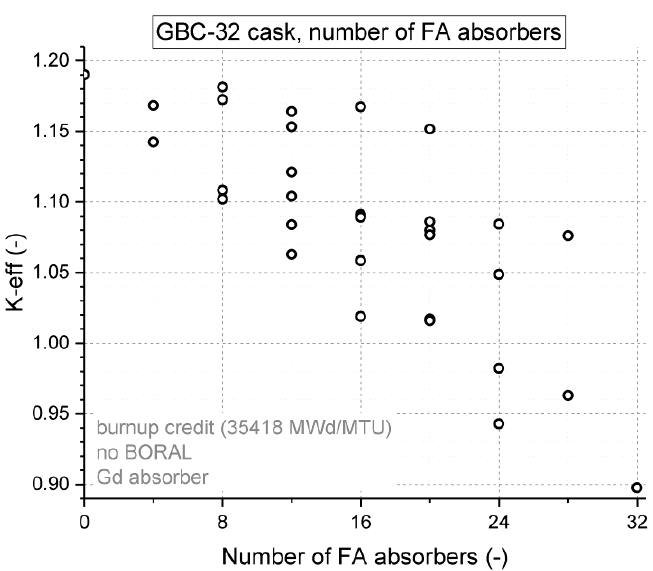
Figure 9. Choosing 24 assemblies out of 32 in the cask loaded with improved absorbers.